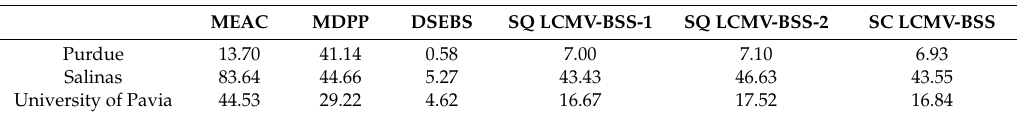
Table 6. Computing time in seconds required by six test BS methods: MEAC, MDPP, DSEBS,